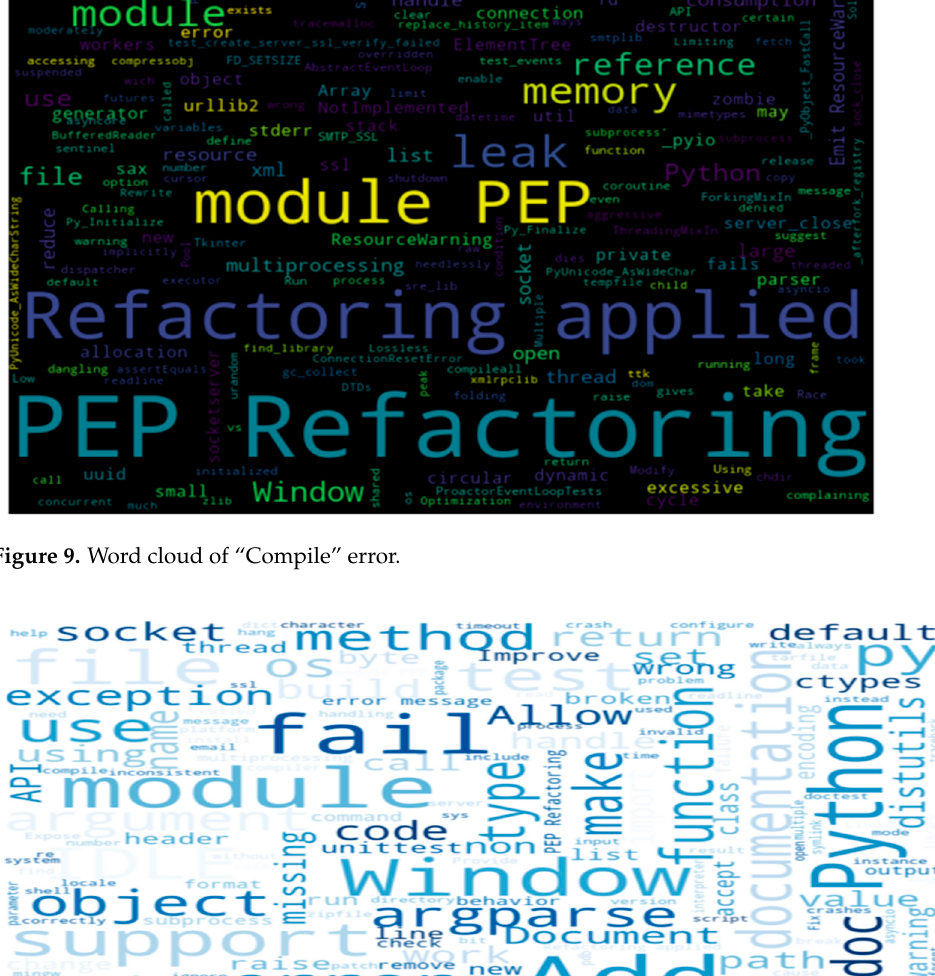
Figure 10. Integrated word cloud of all errors.